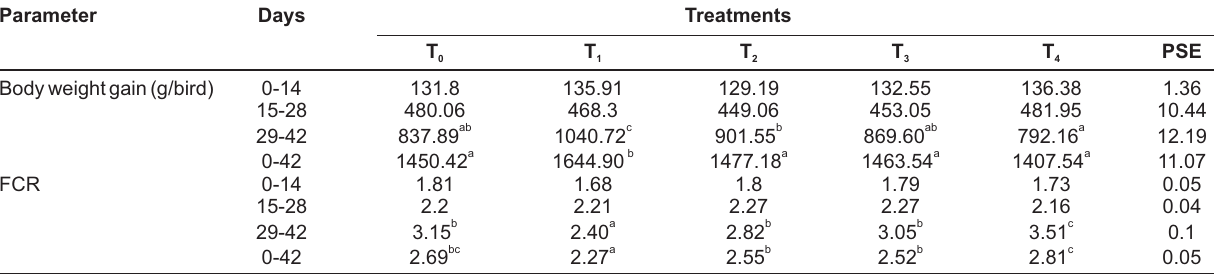
Table-2. Growth performance of broiler chicks supplemented with Enterococcus strain